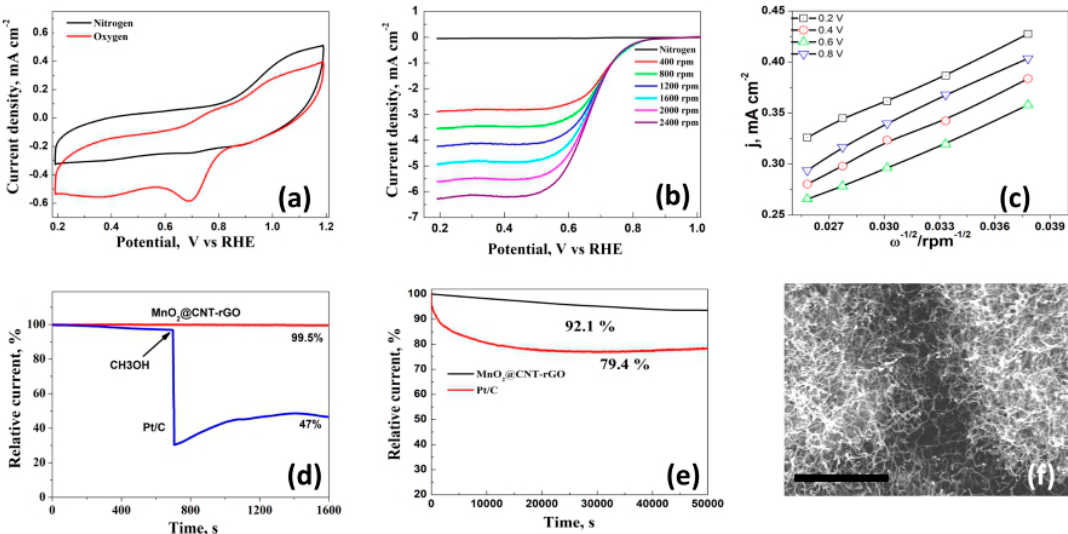
Figure 3. Cyclic voltammograms (CV) of MnO 2 @CNT-rGO electrodes in 0.1 M KOH saturated with N 2 (black) and O 2 (red) at a sweep rate of 50 mVs − 1 ( a ); linear sweep voltammetry (LSV) curves of MnO 2 @CNT-rGO in 0.1 M KOH at rotation speeds ranging from 400 to 2400 rpm ( b ); corresponding K–L plots of MnO 2 @CNT-rGO at various potentials ( c ); Methanol tolerance test of MnO 2 @CNT-rGO and commercial Pt / C ( d ); variation in residual current with time in MnO 2 @CNT-rGO and commercial Pt / C ( e ) and post-mortem SEM micrograph of ( f ) of MnO 2 @CNT-rGO after cycling in 0.1 M KOH ( f ), scale bar is 1 µm.